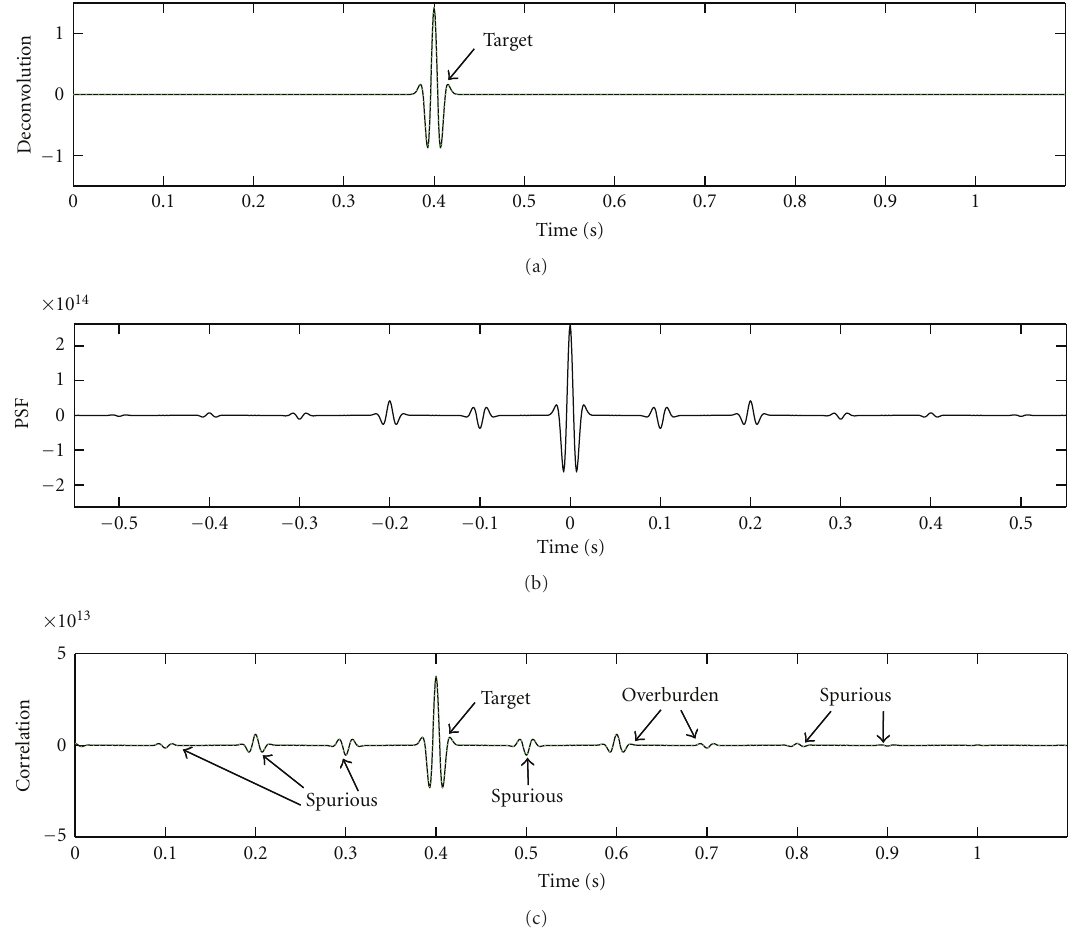
Figure 18: Deconvolution of decomposed fields for model D: (a) retrieved Green’s function (black) and the reference response (dashed green); (b) point spread function Γ dcp ; (c) convolution of the reflection response with the PSF (black) and the correlation function C dcp (dashed